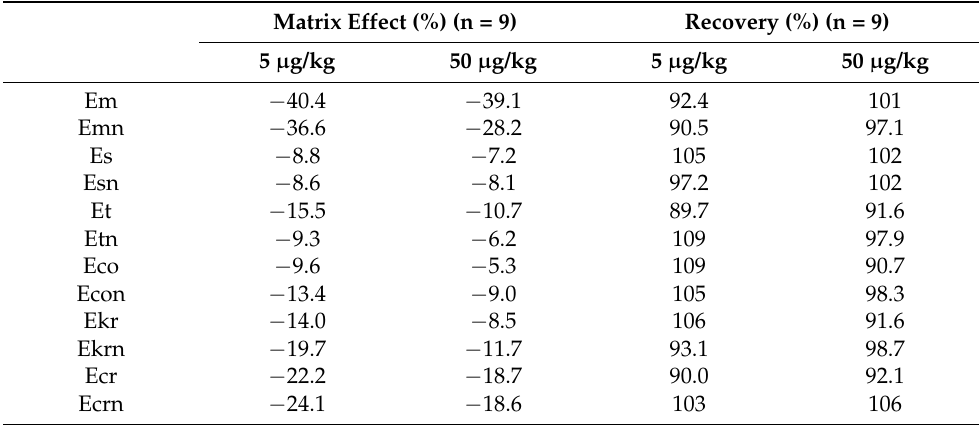
Table 3. Matrix effect and recovery studies of the proposed UHPLC–MS/MS method for the determi- nation of EAs and their epimers in spiked oat flake samples. Matrix Effect (%) (n =